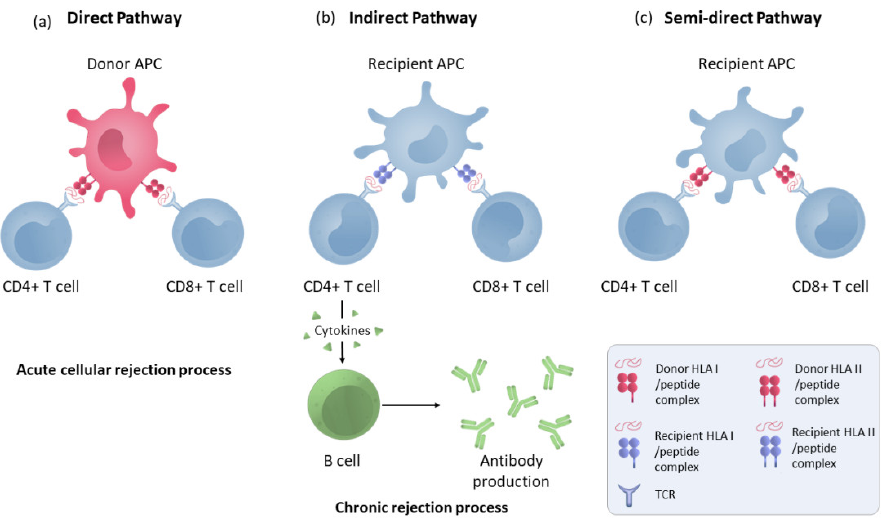
Figure 1. Direct, indirect and semi-direct allorecognition pathways. ( a ) T-lymphocyte direct pathway activation by HLA molecule presentation by donor APCs to the recipient’s T cells. ( b ) Indirect pathway recognition by T CD4 and CD8 cells in which the alloantigens presented as peptides processed by recipient APCs through self-HLA molecules. CD4+ lymphocytes activate B cells to make antibodies. ( c ) T-cell semi-direct pathway activation: T cells recognise intact HLA molecules from the donor, but their own APC presents